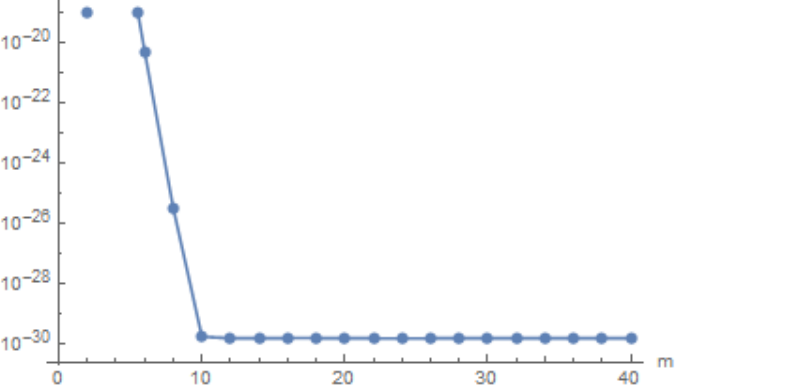
Figure 2. Total residual error, with S z = − 0.1, M x = 0.1, M y = 0.3, R m = 0.01, and S = 1.